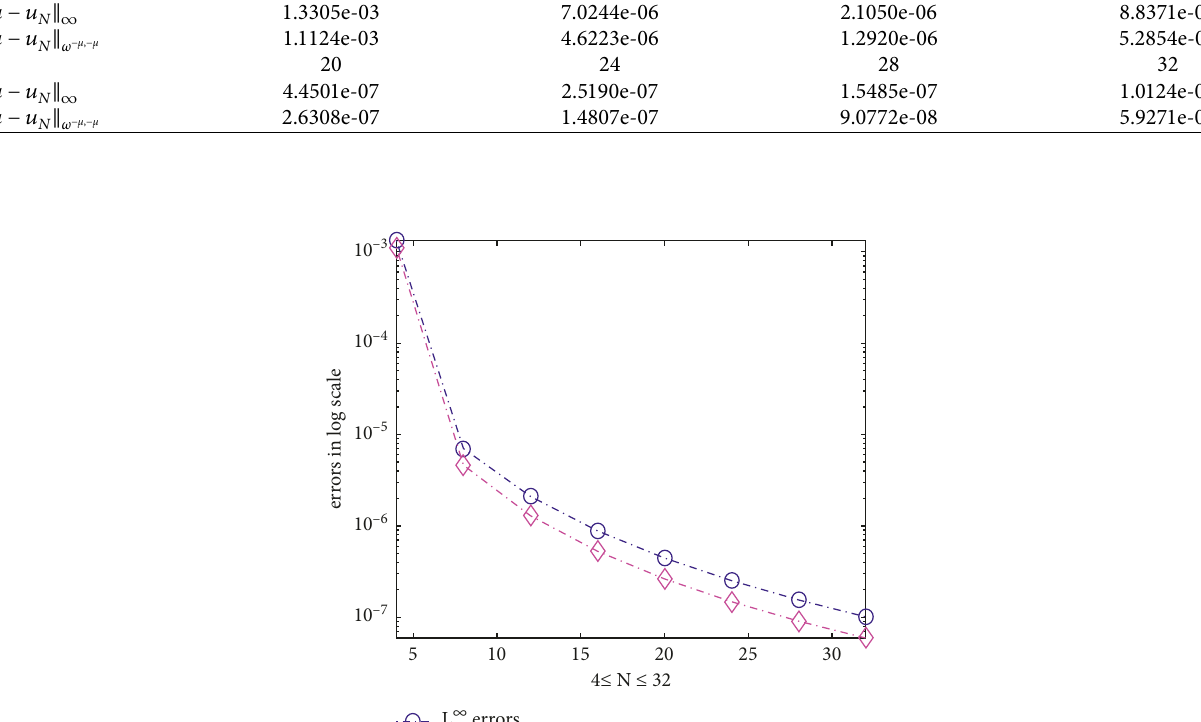
and L ω errors for Example 1. − μ , − μ ∞